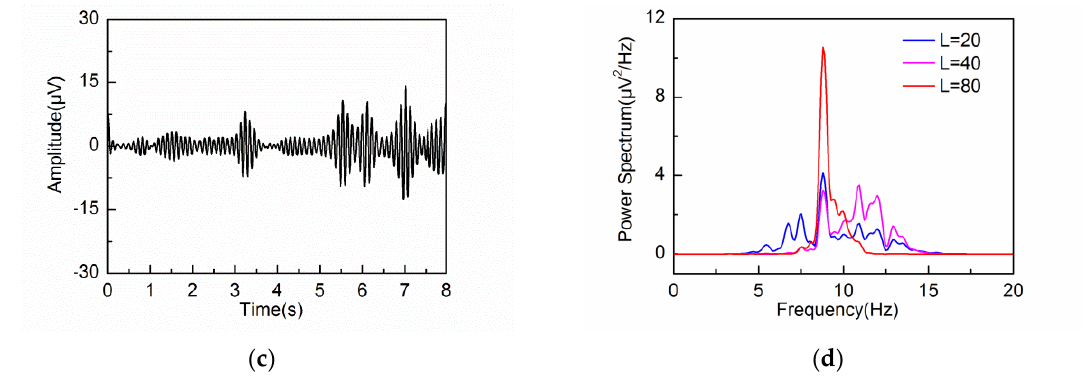
Figure 11. Extracted alpha rhythm under eyes-open condition: ( a ) L = 20; ( b ) L = 40; ( c ) L = 80; ( d ) PSD of the extracted alpha rhythm by different L.